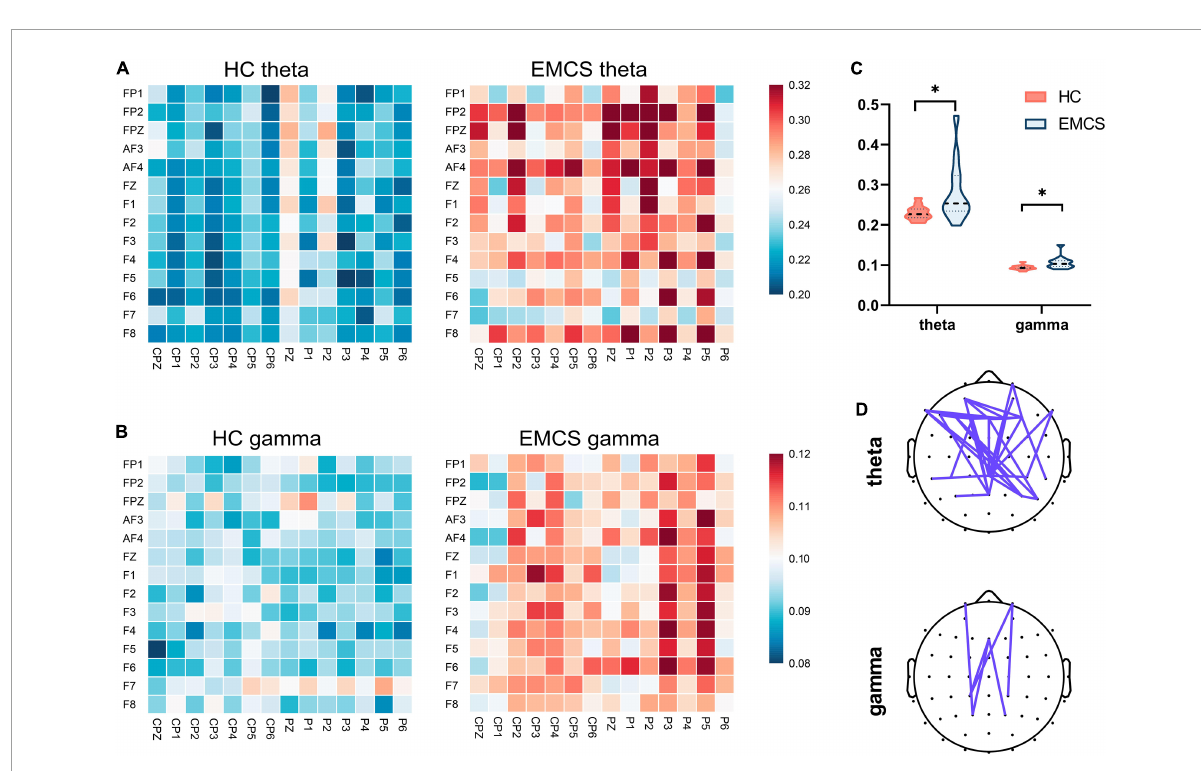
FIGURE2 Frontoparietal weight phase lag index (wPLI) among healthy control (HC) group and emergence from minimally conscious state (EMCS) group. (A) Heatmaps of averaged wPLI values at rest for theta band between the groups. (B) Heatmaps of averaged wPLI values at rest for gamma band. The wPLI values were implemented Fisher-Z transformed. (C) Violin plot of wPLI values between frontal and parietal areas in theta and gamma bands ( ∗ P < 0.01, after Bonferroni correction). (D) The top panel shows significantly altered connectivities between the two groups. The purple line means significantly increased connectivity in EMCS